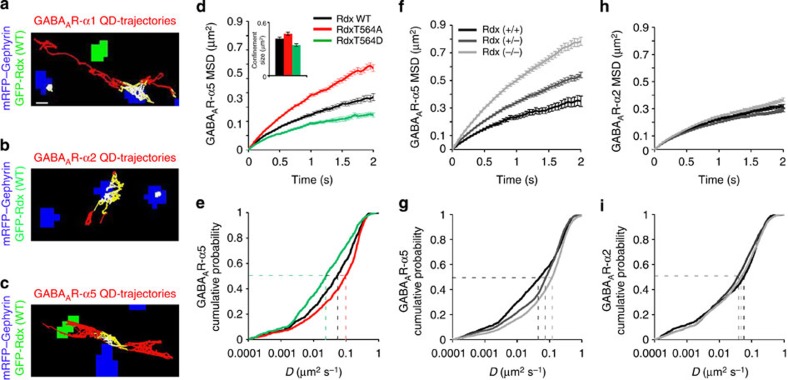
Rdx inactivation or depletion increases lateral diffusion of GABAAR-α5 within the plasma membrane.(a–c) Representative quantum dot (QD)-trajectories of GABAAR-α1, GABAAR-α2 and GABAAR-α5 in hippocampal neurons expressing mRFP–gephyrin (synaptic marker, blue) and GFP–Rdx (extrasynaptic marker, green). Receptor trajectories: outside of gephyrin clusters (red), peripheral (yellow) and inside clusters (white). (d,e) Diffusion of GABAAR-α5 outside of Rdx clusters in hippocampal neurons expressing Rdx-WT (black), RdxT564A (red) or RdxT564D (green). (d) Mean square displacement (MSD) versus time plot for GABAAR-α5-QD trajectories. Inset: average size of GABAAR-α5-QD confinement domains for Rdx-WT (0.416±0.017 μm2), RdxT564A (0.472±0.018 μm2) or RdxT564D (0.344±0.015 μm2) (RdxT564A versus Rdx-WT: P<0.05; RdxT564D versus Rdx-WT: P<0.01, t-test). (e) Cumulative probability plot for GABAAR-α5-QD diffusion coefficients. Dashed lines: median diffusion coefficients for RdxT564A (0.095 μm2 s−1: P<0.001) and RdxT564D (0.024 μm2 s−1: P<0.001) compared with Rdx-WT (0.053 μm2 s−1) (KS test). (f–i) Diffusion of GABAAR-α5 and GABAAR-α2 in hippocampal neurons derived from WT (+/+) (black), Rdx (+/−) (dark-grey) or Rdx (−/−) (light-grey) mice. (f) MSD versus time plot for GABAAR-α5-QD trajectories. Average size of GABAAR-α5-QD confinement size for Rdx (−/−) compared with Rdx (+/−) and WT (+/+);P<0.001 (t-test). (g) Cumulative probability plot of GABAAR-α5-QD diffusion coefficients. Dashed lines: median diffusion coefficients for Rdx (−/−) (0.121 μm2 s−1) compared with Rdx (+/−) (0.077 μm2 s−1) and WT (+/+) (0.050 μm2 s−1) (P<0.01, KS test). (h) MSD versus time plot for GABAAR-α2-QD trajectories. (i) Cumulative probability plot for GABAAR-α2-QD diffusion coefficients. Dashed lines: median diffusion coefficients for Rdx (−/−) (0.046 μm2 s−1) compared with Rdx (+/−) (0.039 μm2 s−1) and WT (+/+) (0.057 μm2 s−1) (P=NS, KS test). Scale bars, 500 nm. Error bars, mean±s.e.m. NS, not significant.